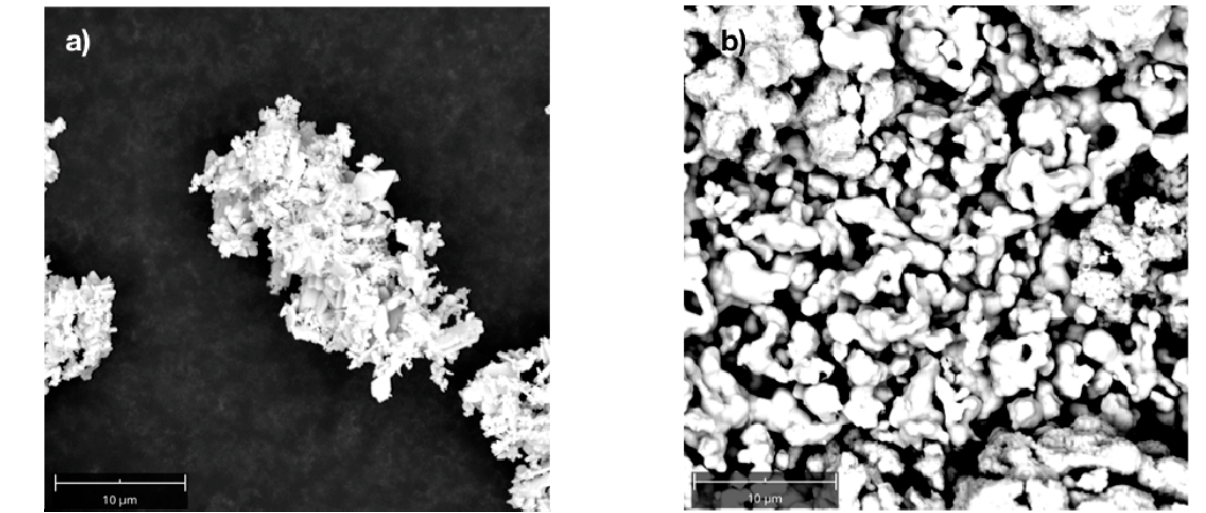
Figure 2. Example of an SEM image of the investigated AgNPs in a solid sample. Evidence of a typical charge effect of nonconductive samples (specimen) that were not treated with a “coated technique”. ( a ) The figure was obtained with the drop technique on a metal sample holder (specimen) covered with charcoal. ( b ) The figure represents the magnification useful for the elementary analysis.